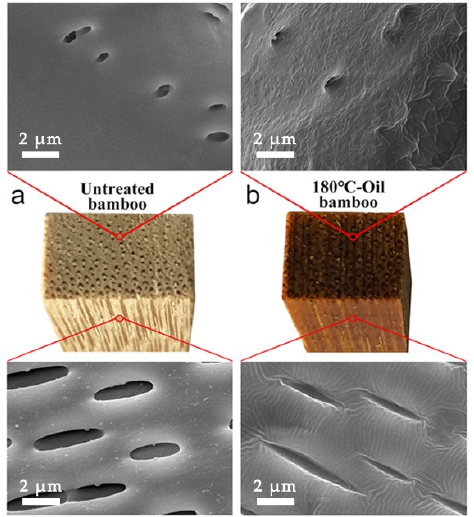
Figure 3. Macroscopic and microscopic morphology of moso bamboo: ( a ) untreated bamboo; ( b ) 180 °C -Oil bamboo.